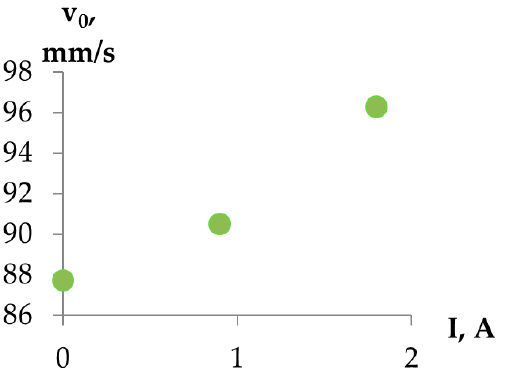
Figure 6. Dependence of the droplet velocity on the change in the current applied to the solenoid.